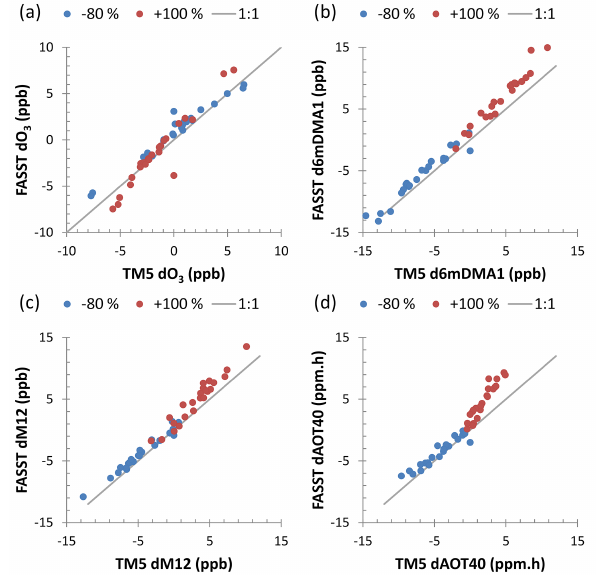
Figure 7. Regional O 3 and O 3 exposure metric responses to com- bined − 80% and + 100% precursor emission perturbations of NO x and NMVOCs. (a) Annual mean population-weighted O 3 ; (b) population-weighted 6mDMA1; (c) area-mean M12; (d) area- mean AOT40. The x axis shows the full TM5 model; the y axis shows the linear extrapolation of − 20% perturbation (FASST ap- proach). Each point corresponds to the mean metric over a source